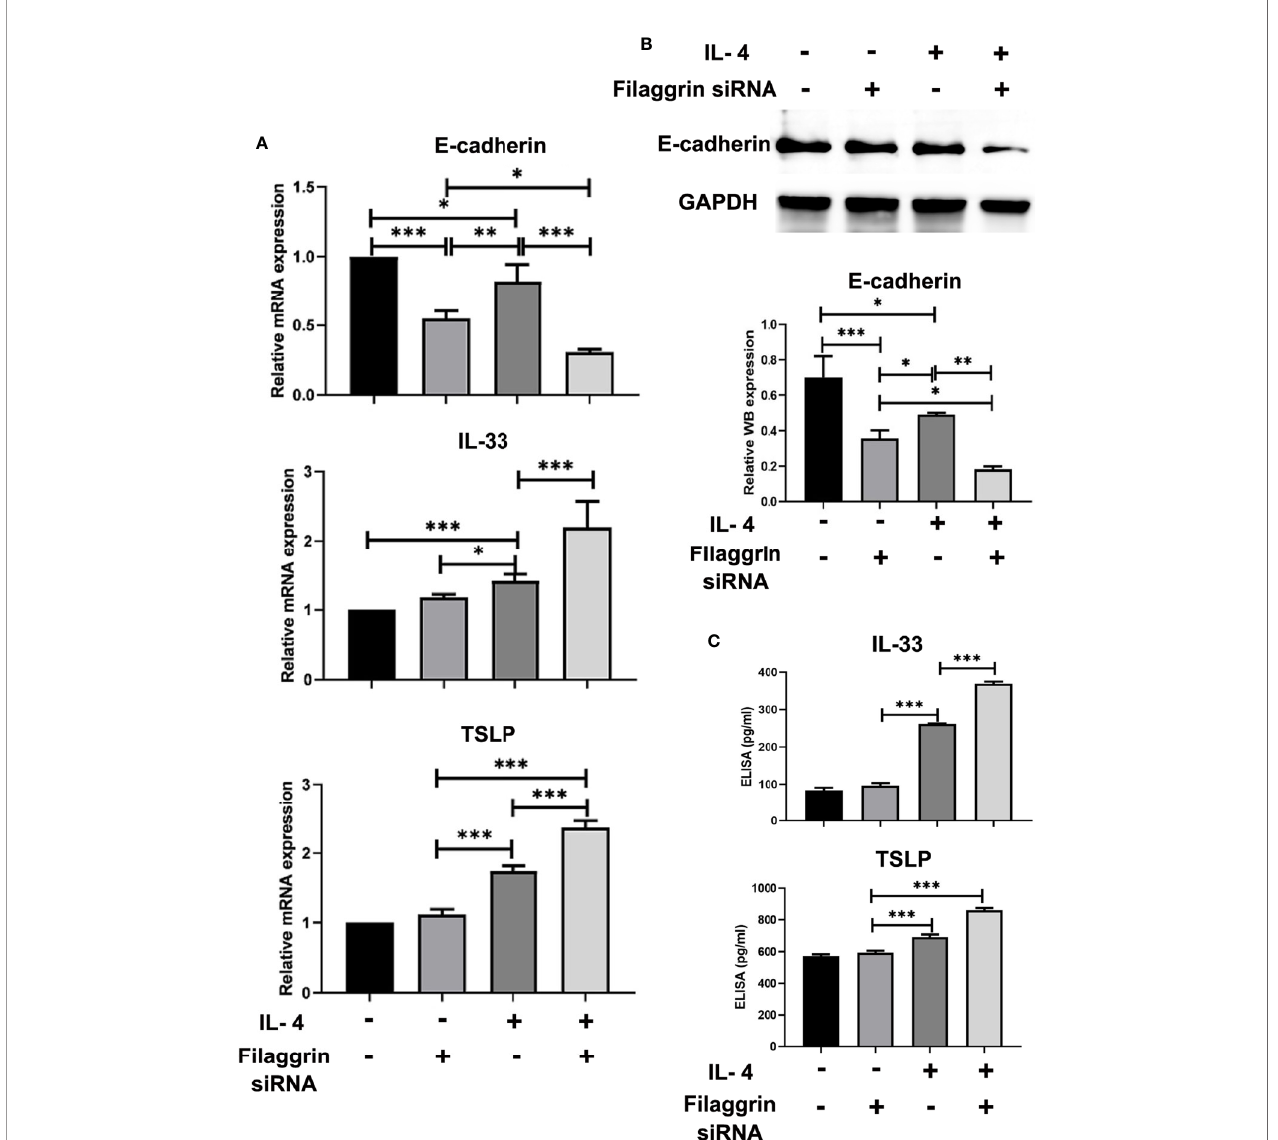
FIGURE 8 | The expressions of E-cadherin, TSLP and IL-33 were more signi fi cantly modulated by IL-4 treatment after knock-down of fi laggrin with speci fi c siRNA. As same as the description in previous fi gure legend, BEAS-2B cells were divided into four groups: siRNA NC group (control group), fi laggrin siRNA group, IL-4 inducted group and fi laggrin siRNA + IL-4 inducted group. (A) The mRNA expression of E-cadherin, IL-33 and TSLP among the four groups detected with RT-PCR. (B) The protein levels of E-cadherin in the four groups were detected with Western-blot. (C) Levels of IL-33 and TSLP in the cell culture supernatant of the four groups were measured by ELISA. Each experiment has been repeated for 3 times and presented as the mean ± standard deviation (n=3). And the Student ’ s t-test was used to analyze the difference between groups. *P < 0.05; **P < 0.01; ***P <